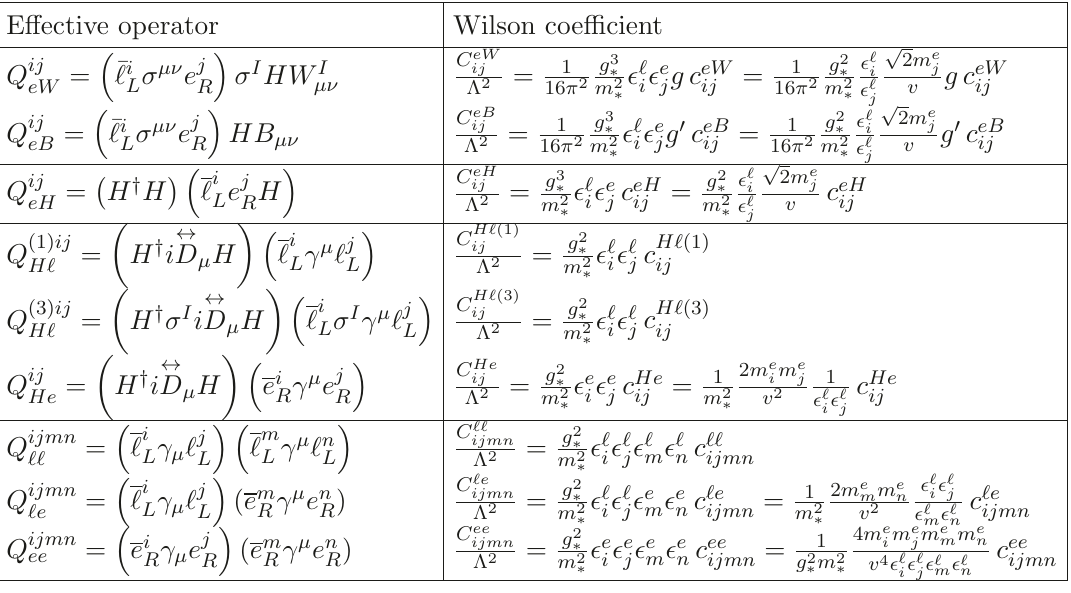
Table 3 . Dimension-six operators involving leptons and no quarks, and the NDA estimate of their Wilson coefficients, in the anarchic PC scenario. In the last equalities we used eq. (2.8) to eliminate the parameters ǫ e in favour of ǫ ℓ i i